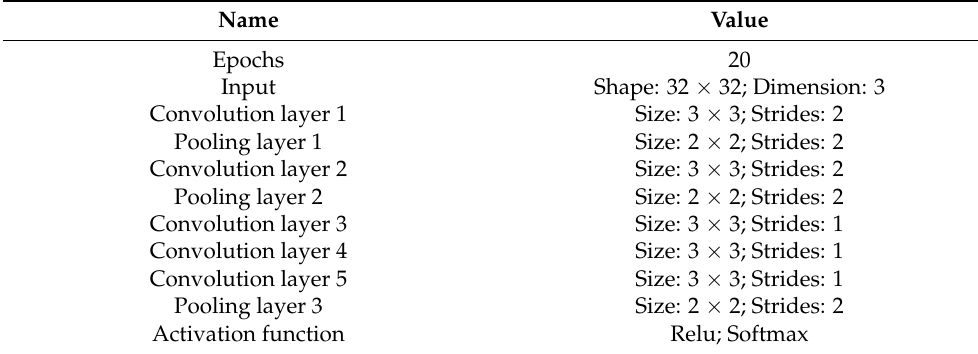
Table 6. Parameter settings of the complex convolutional neural network that remain